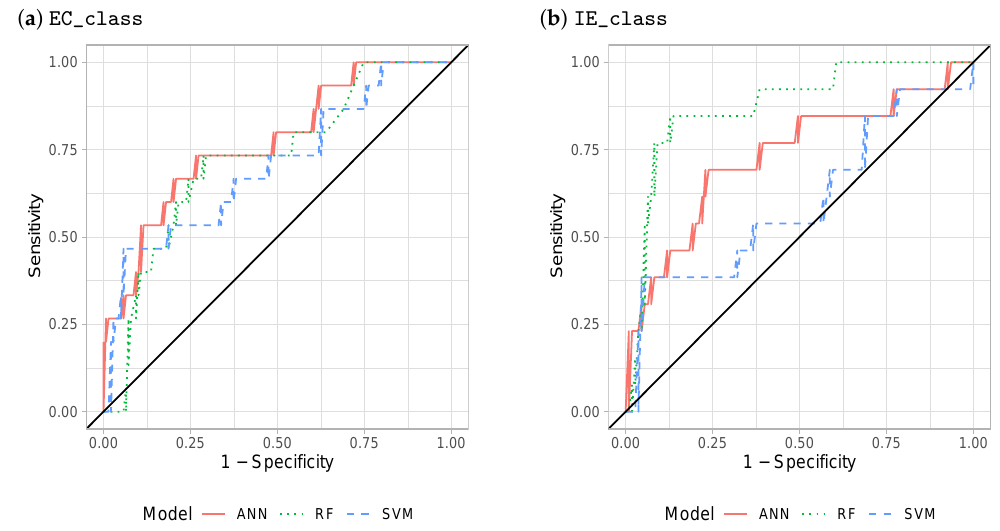
Figure 10. ROC of different classifiers (ANN, RF, and SVM) for EC_class and IE_class